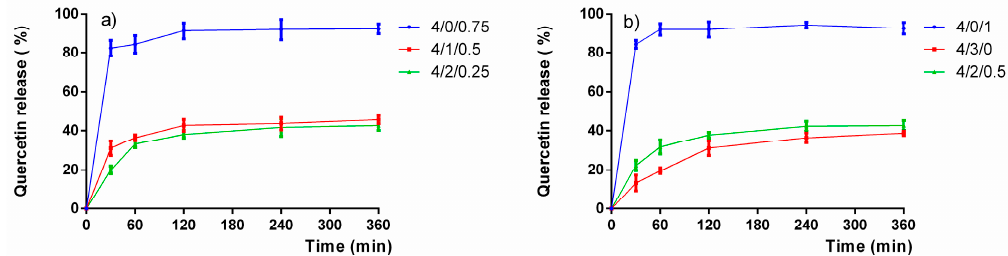
Figure 7. Quercetin in vitro release profile of selected loaded nanoparticles of CS 70/5 ( a ) and CS 70/20 ( b ) in M9 medium at 37 °C (mean ± S.D., n = 3) at varying mass ratios of CS/SBE β CD/TPP shown in labels.